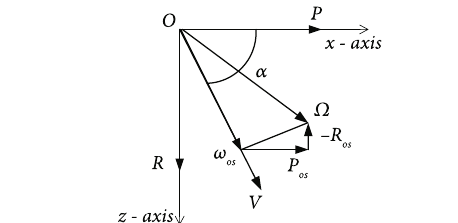
Figure 3: Two-dimensional decomposition of the total angular velocity vector by the fi rst decomposition method.